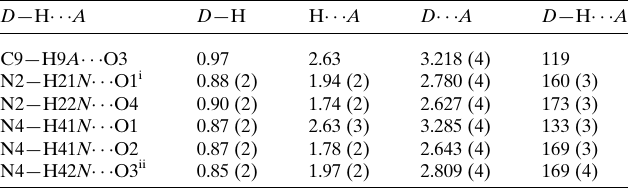
Table 3 Hydrogen-bond geometry (A˚ , (cid:5) ) for 4 .